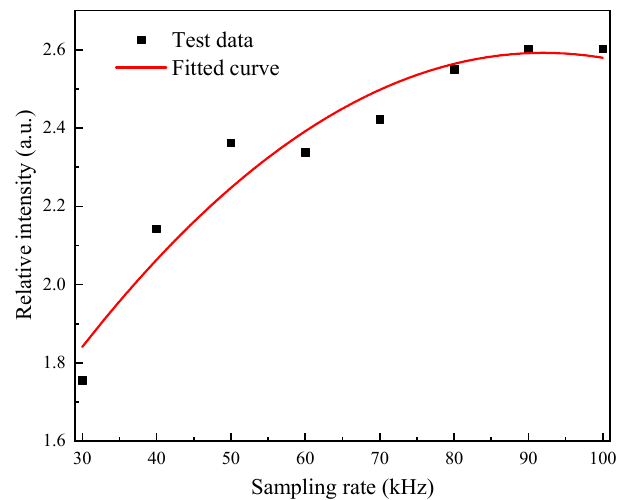
Figure 14. Plot of demodulated signal intensity versus data sampling rate.